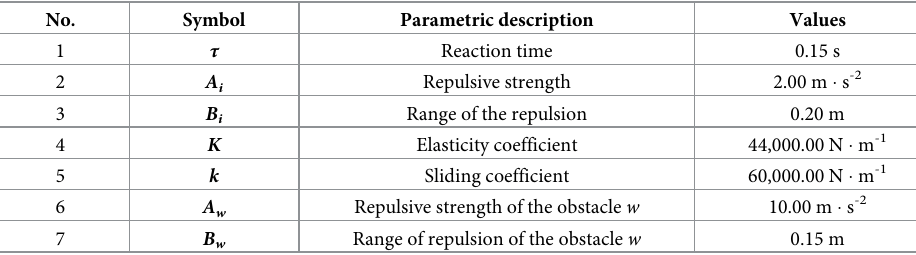
Table 5. Result of SFM parameters for calibration.